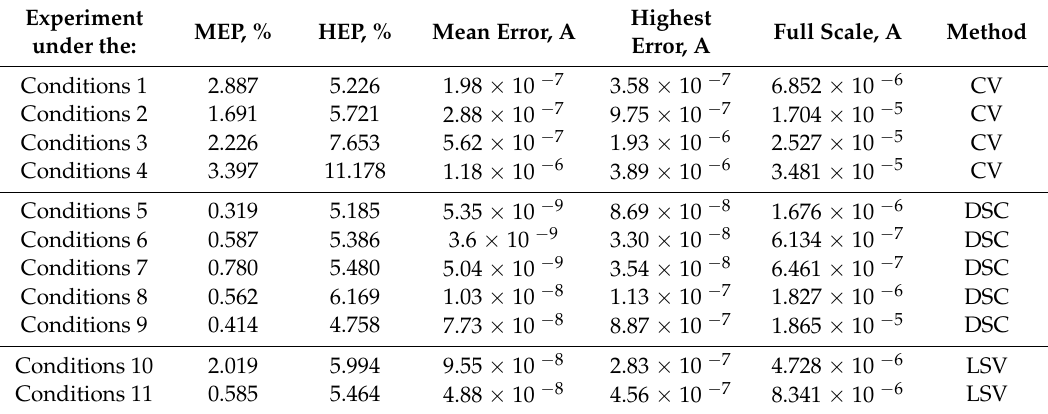
Table 6. Error analysis summary of the CV, DSC and LSV experiments in Figures 6–8 and by using Equations (5–9). Experimental conditions are reported in Tables